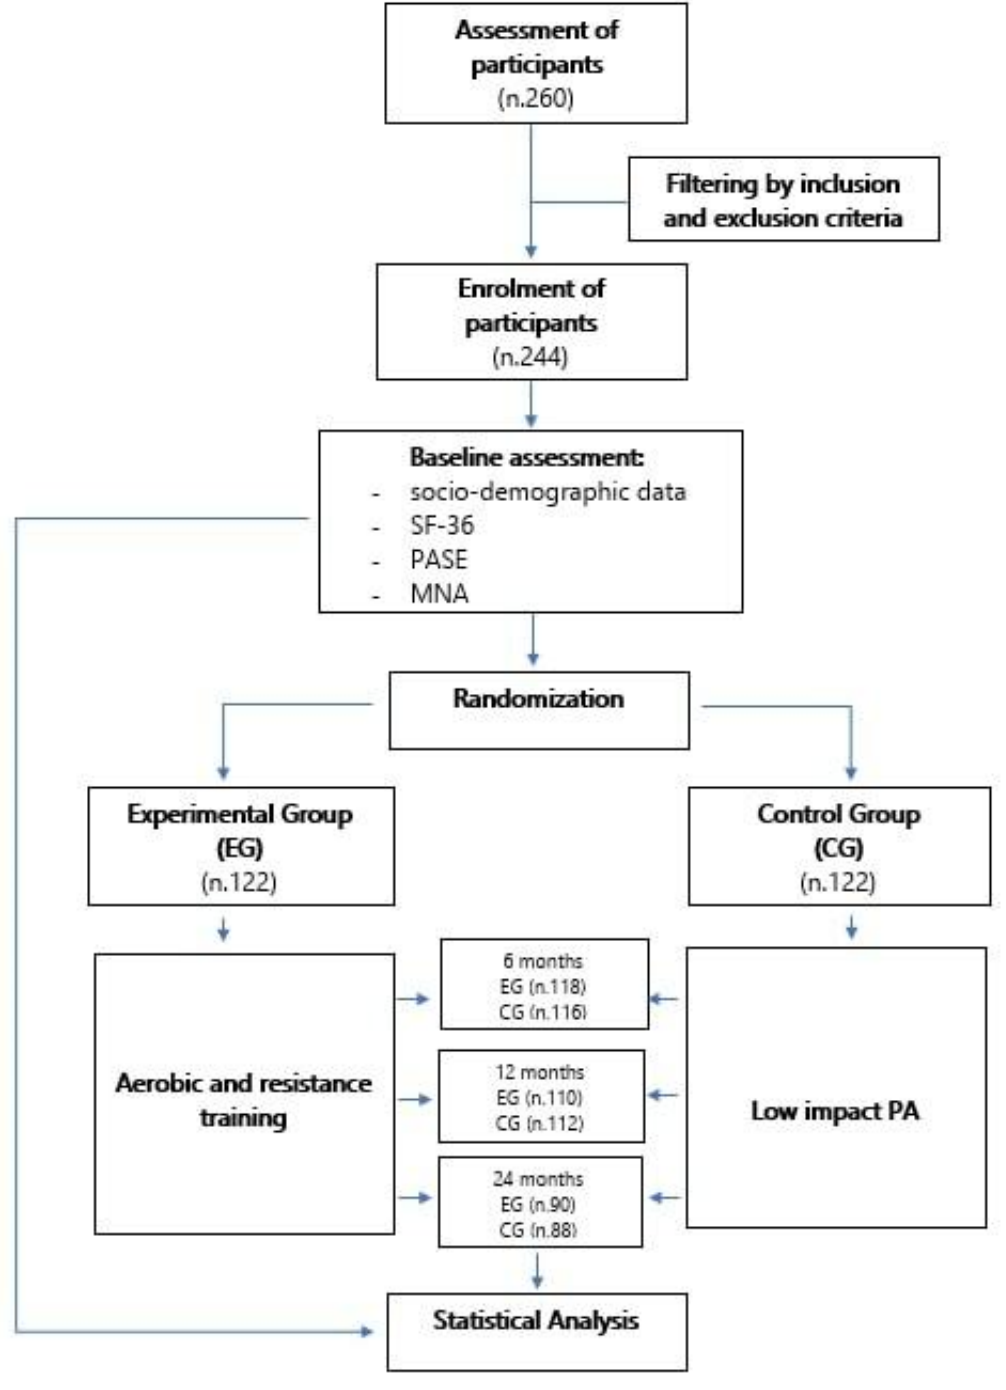
Figure 1. Flowchart of the study.